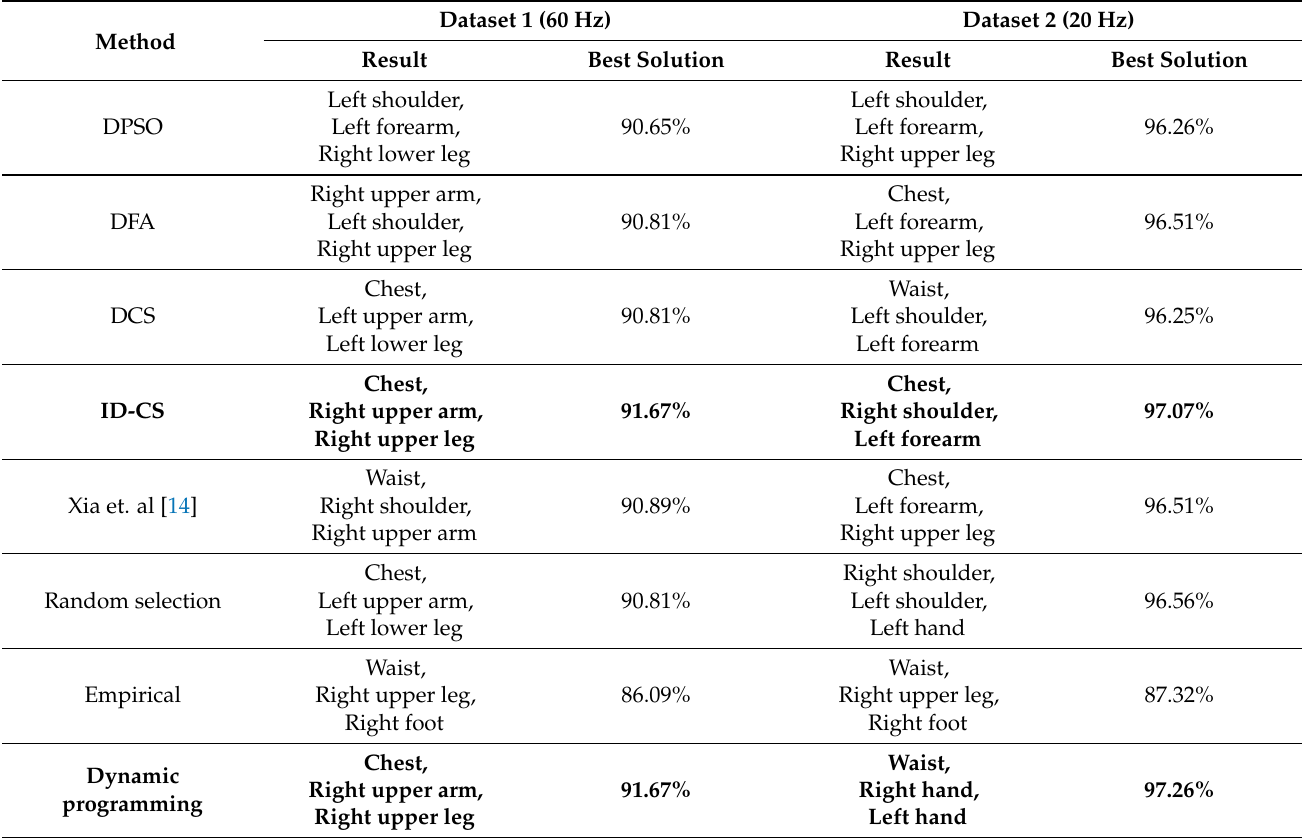
Table 1. Performance comparison of different methods with different sampling rate